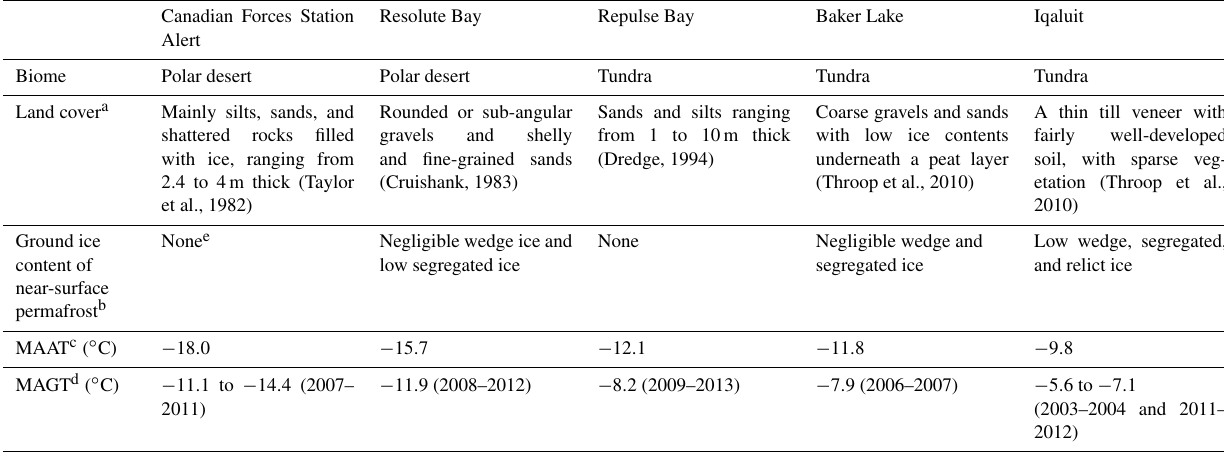
Table 2. Regional background of the study